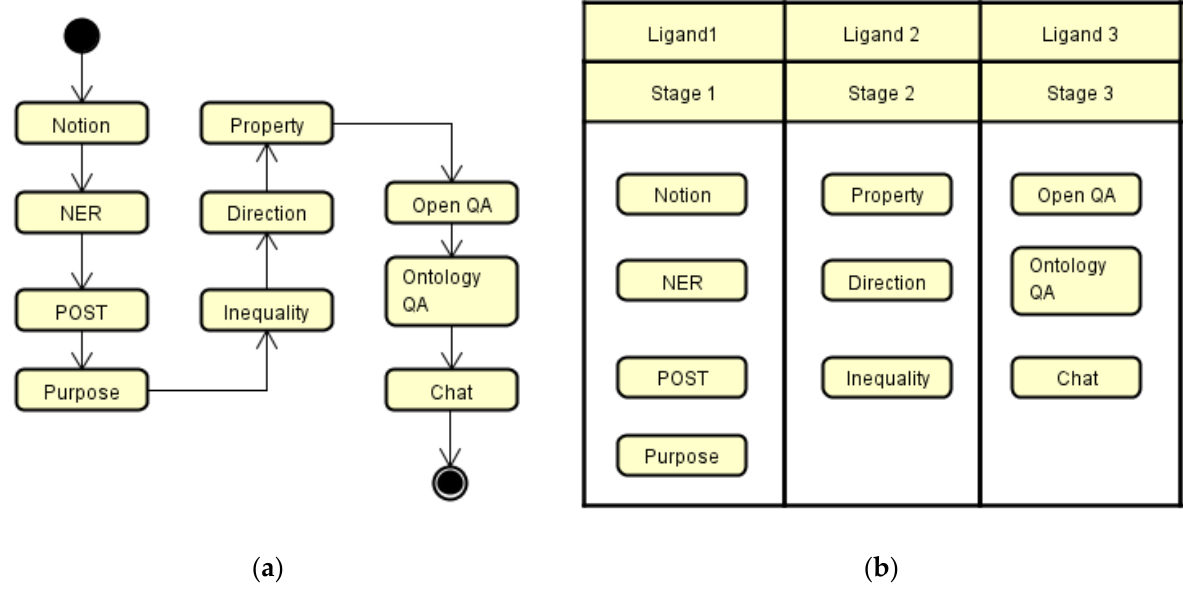
Figure 7. This is a hypothetical example for the CellS framework: ( a ) This is a sequential program; ( b ) This is an equivalent program using the CellS.